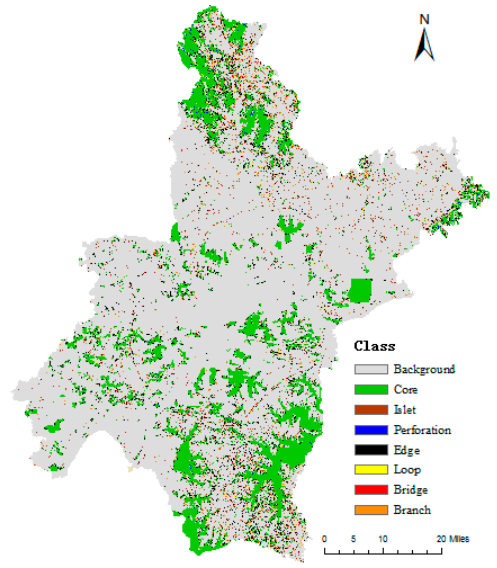
Figure 6. Landscape type analysis map based on MSPA.